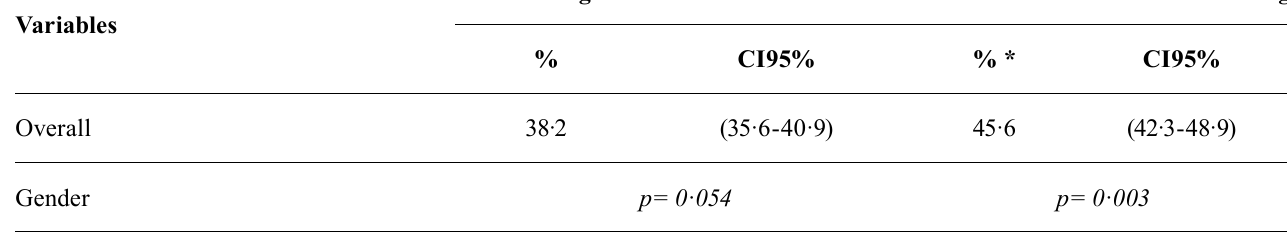
TABLE III – Difficulties of availability of medicines in SUS pharmacy services among adult and elderly (20 years and over) users of the Unified Health System (SUS) with a reported chronic non-communicable disease (NCD), indication of medicine treatment and that obtain some of the medicines in use in the SUS, according to demographic, socioeconomic and health variables. PNAUM, 2014